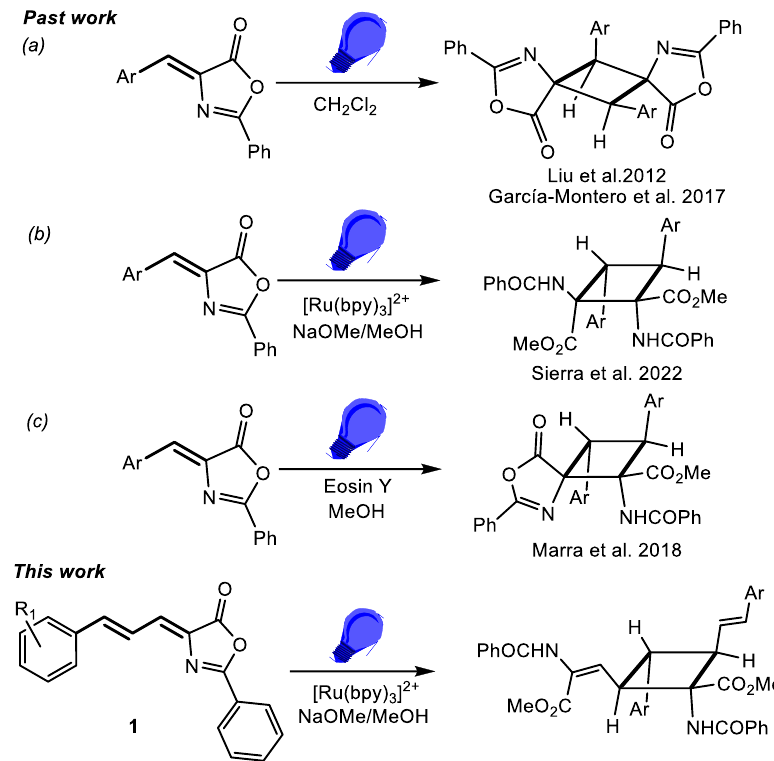
Figure 2. Past work reported on the synthesis of truxillic and truxinic derivatives from irradiation of aryliden-oxazolones: ( a ) direct irradiation of oxazolones giving 1,3-coupling and the epsilon isomer; ( b ) irradiation in presence of a Ru-photosensitizer giving 1,2-coupling and the mu-isomer; ( c ) irradiation in presence of an organic photosensitizer giving 1,2-coupling and the zeta-isomer [26,30–32]. Comparison with the present work from allyliden-oxazolones.